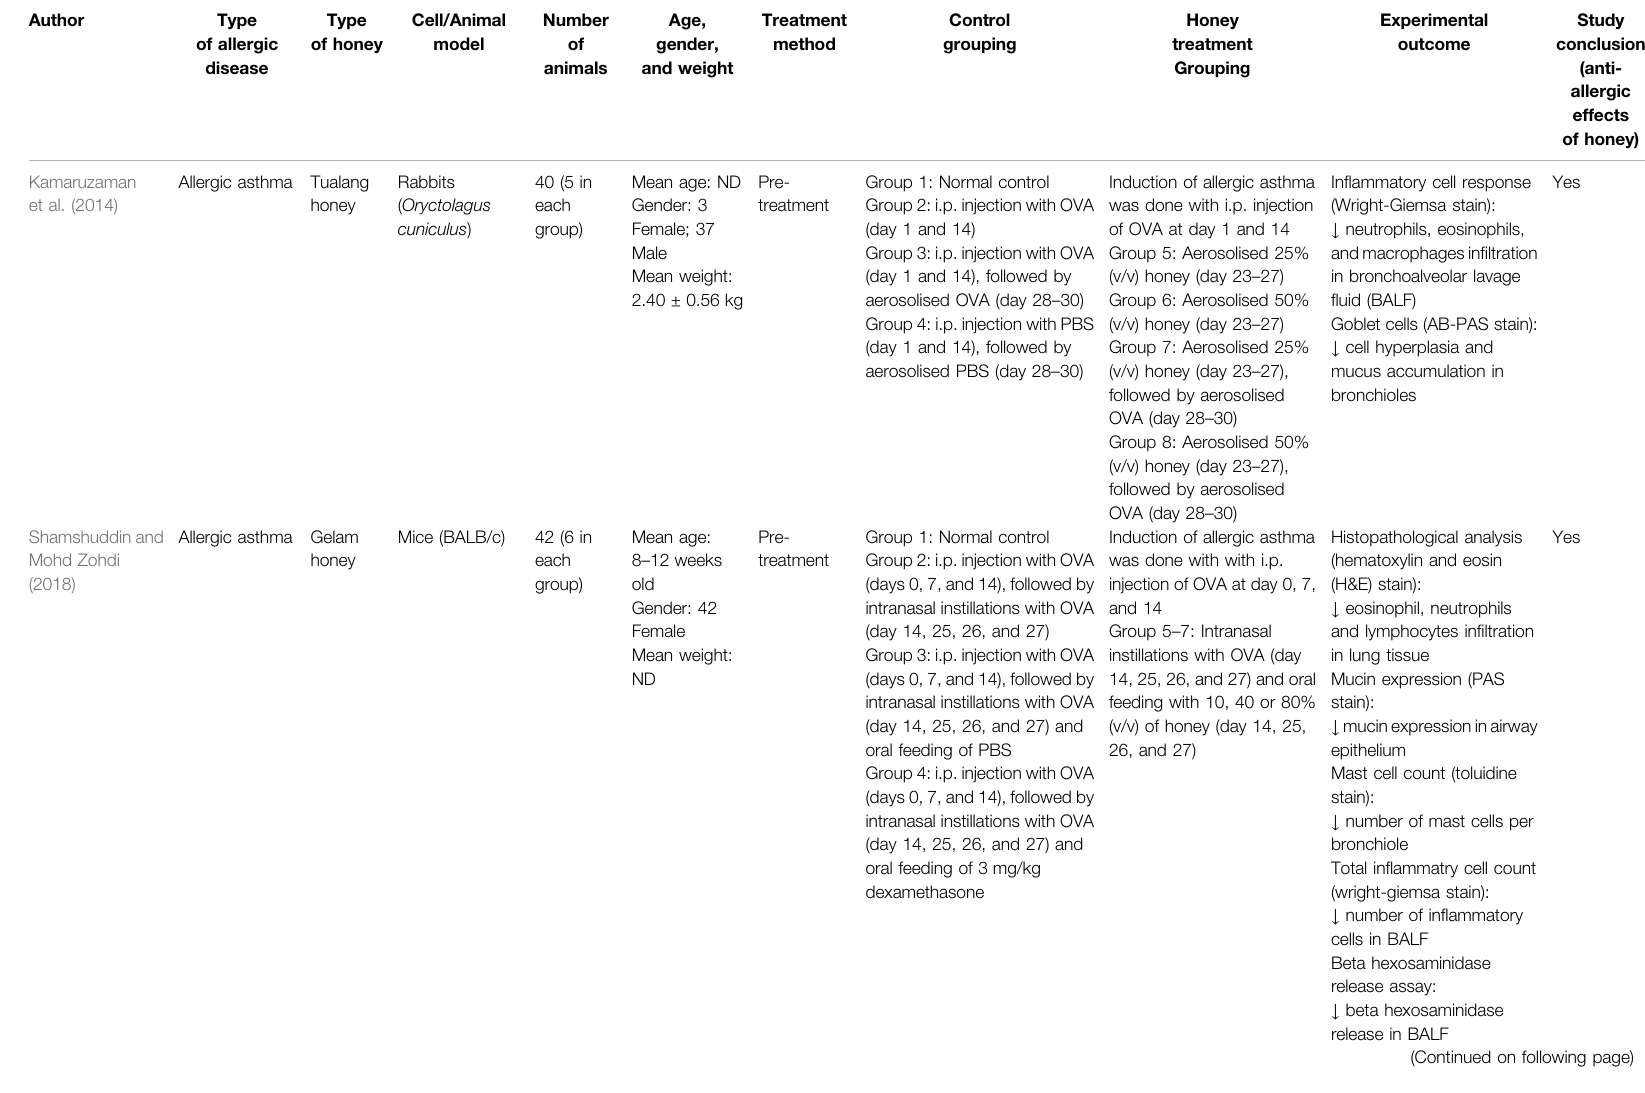
TABLE 3 | Pre-clinical studies on the anti-allergic potential of various types of